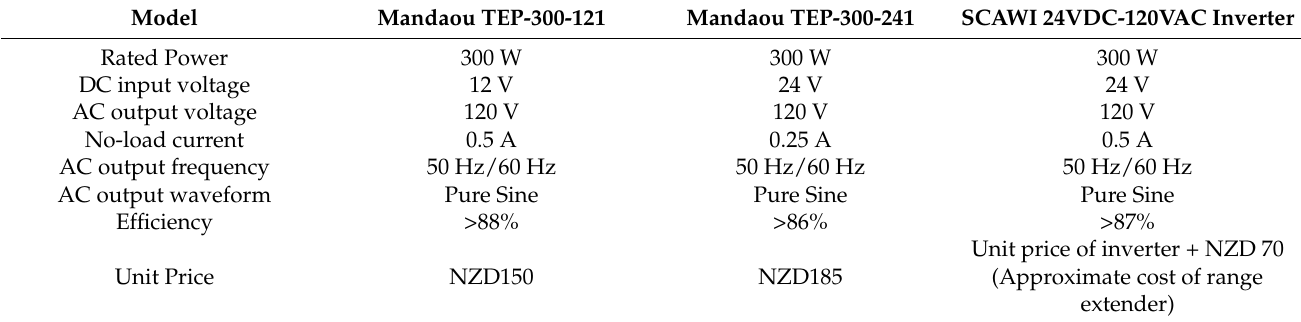
Table 5. Comparison between 12 VDC–120 VAC Inverter, 24 VDC–120 VAC Inverter and 24 VDC–120 VAC SCASWI Inverter.